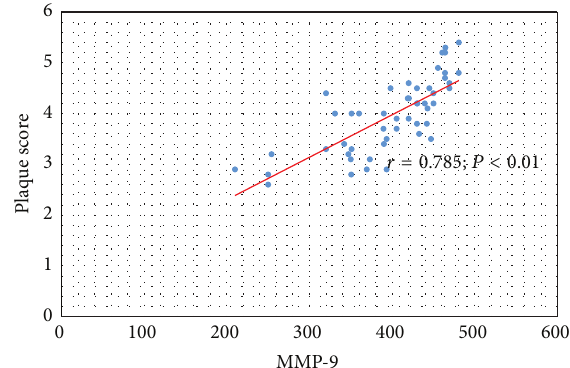
Figure 6: The relation between serum concentration of MMP-9 and value of plaque score in CKD and PD